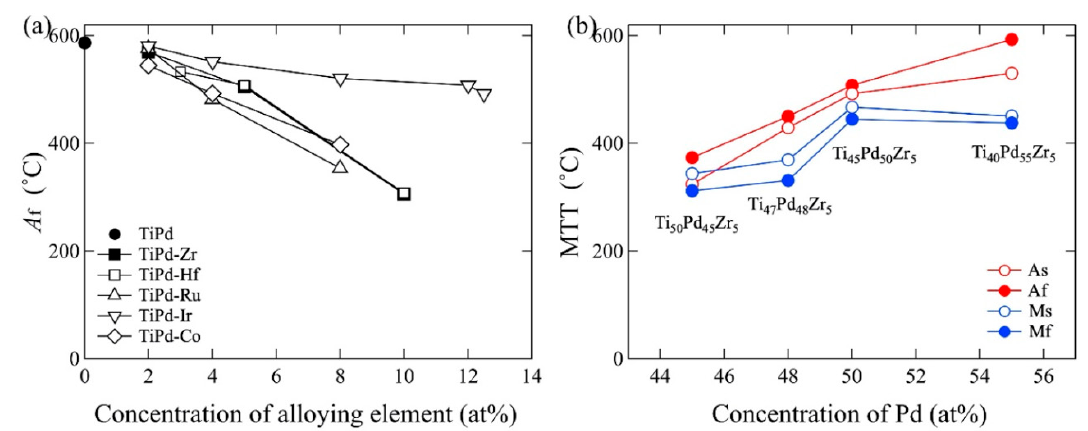
Table 2. Martensitic transformation temperature of multi-element alloys.